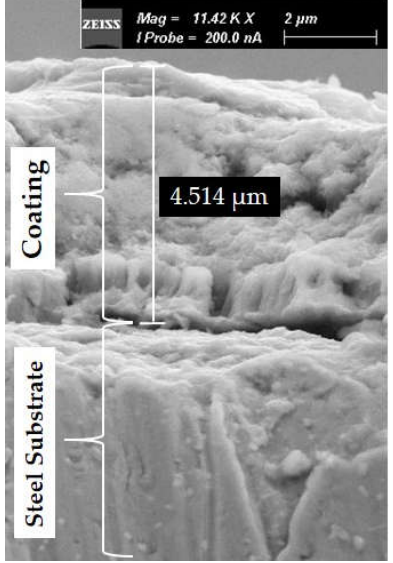
Figure 2. Coating thickness measurement from scanning electron microscopy.